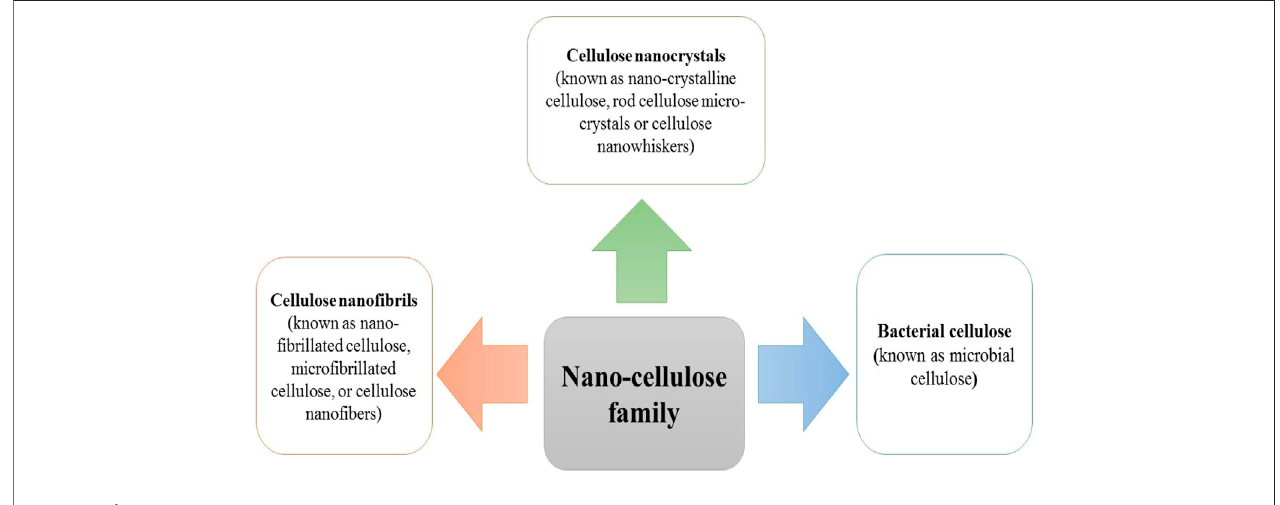
FIGURE 2 | The family of nano-cellulose structures.